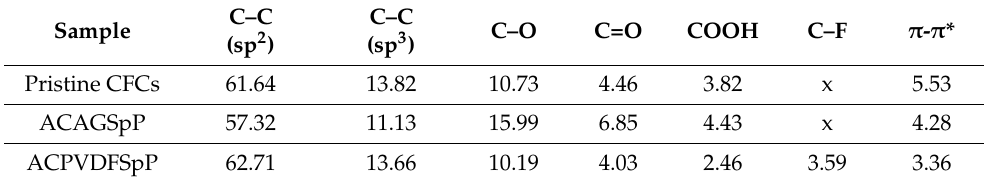
Table 1. XPS curve-fitted results of C 1s